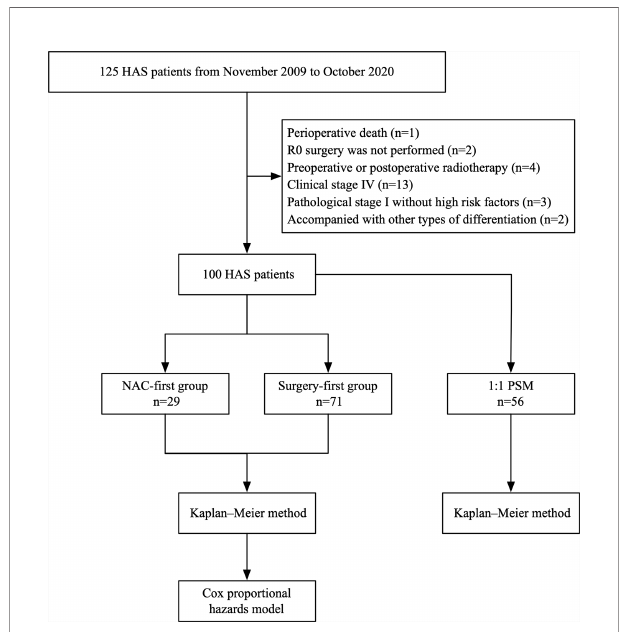
FIGURE 1 | Schematic of the study design. The chart showed the selection of patients and study